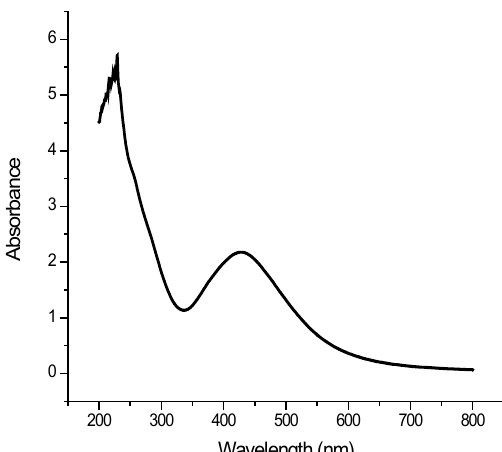
Fig. 3 (a): Time dependent Biosynthesis of GS-SAgNPs Fig. 2(a): UV-VIS Spectra of GS-SAgNPS at 3mM AgNO